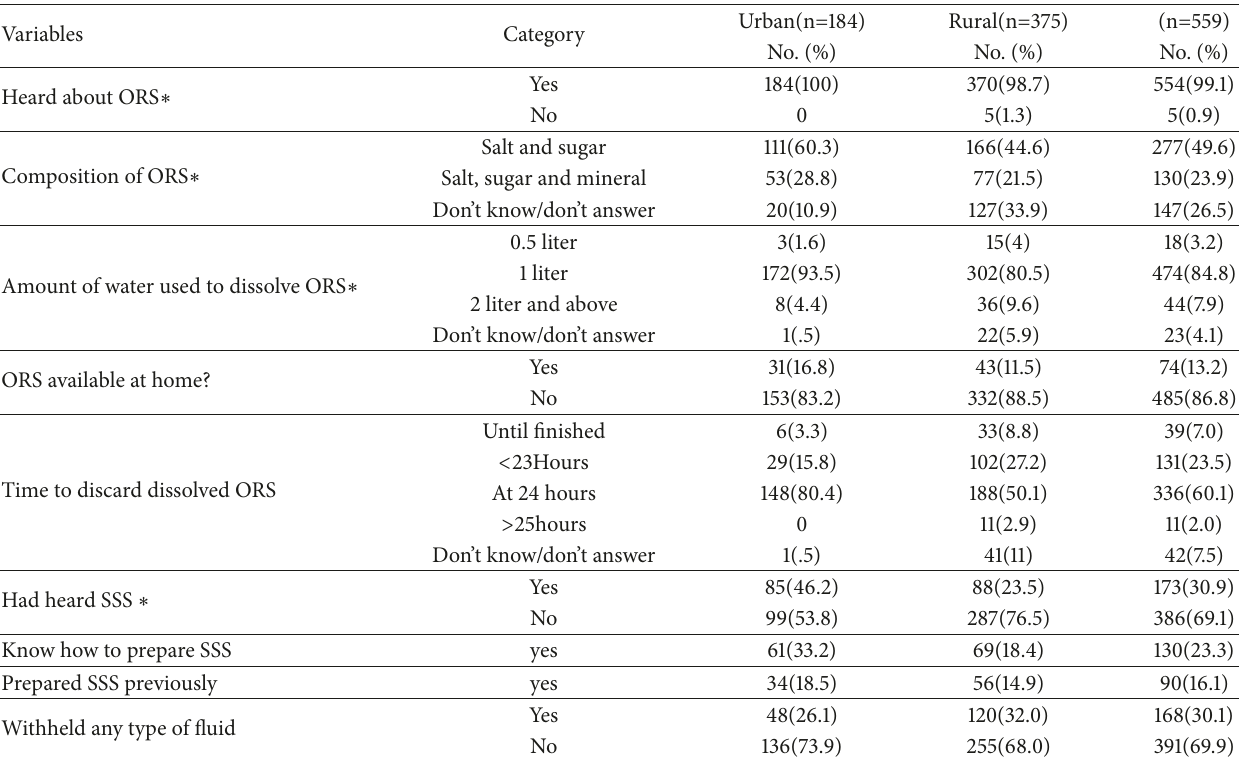
Table 2: Awareness on fluid intake among caregivers of under-five children’s in urban and rural resident of Doba woreda, Ethiopia.